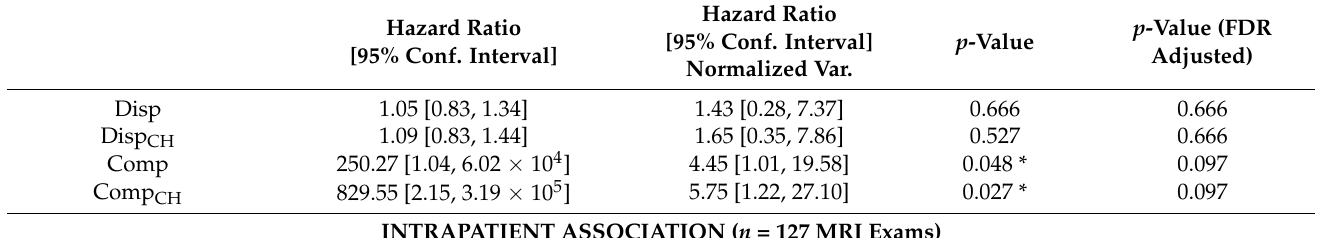
Table 1. Results for the Cox regression analyses and their associations with patient prognostic. The interpatient association analysis shows the results of the uniparametric Cox regression for biomarkers to predict OS. The interpatient association analysis shows the results of the multiparametric Cox regression for biomarkers to predict OS. To eliminate the dependency on each patient, we included whether each biomarker value belonged to each patient as a binary co-variable. Asterisk * indicates significant difference ( p < 0.05).